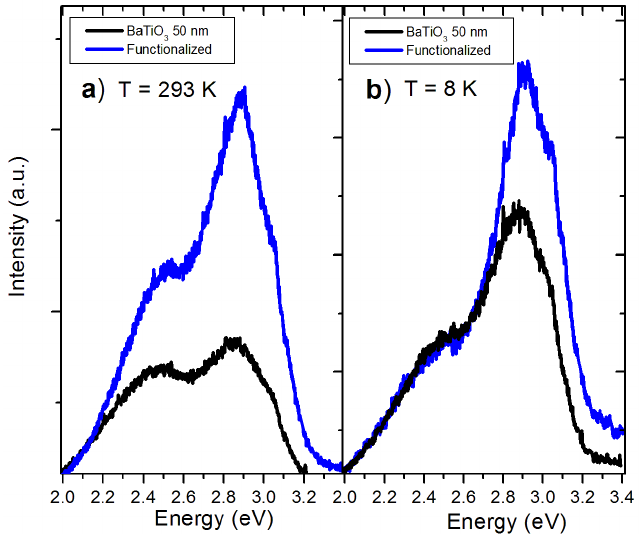
Figure 6. ( a ) Comparison of PL spectra of pure BTO50 powder with APTES functionalized powder; ( b ) Comparison at 8 K.